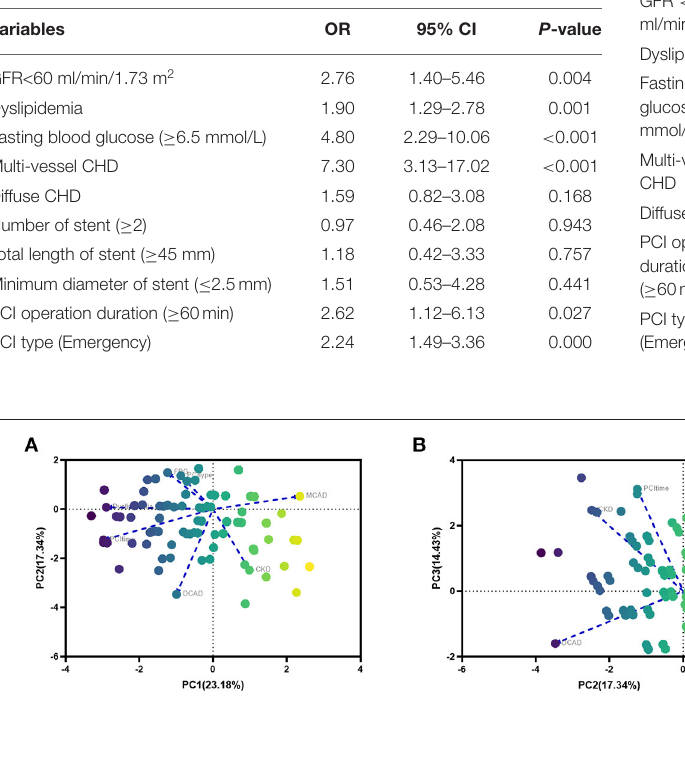
TABLE 2 | Univariate models for DES-ISR in the propensity matched population.